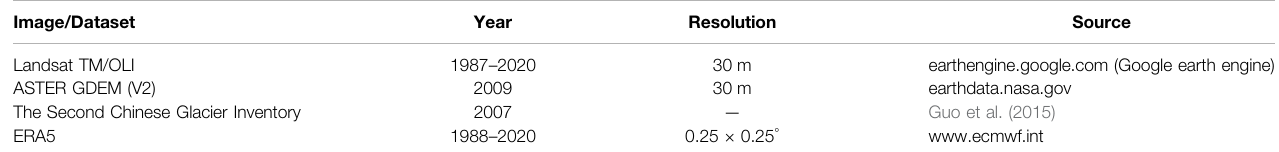
TABLE 1 | Descriptions of the images and data used in this study.